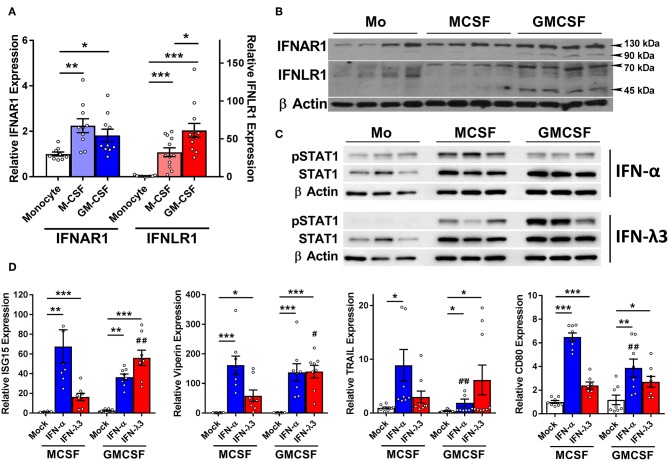
M-CSF and GM-CSF differentiated macrophages respond differently to IFN-α and IFN-λ3. Following M- and GM-CSF stimulated differentiation, IFN-λ responsiveness of Mϕ populations was examined, and compared to IFN-α. M-CSF and GM-CSF Mϕ subsets both increased the expression of IFNAR1 ~2-fold following differentiation from monocytes, and IFNLR1 transcripts ~30- and 60-fold, respectively (A) (n ≥ 9). Western blot of IFNAR1 and IFNLR1 from four healthy subjects confirmed these findings (B) (n = 7, total). Supporting these findings, phosphorylation of STAT1 was detected by Western blot in both monocytes and macrophages following 15 min of IFN-α treatment and macrophages only following IFN-λ3 (C). ISG transcripts for ISG15, viperin, CD80, and TRAIL were examined to measure Mϕ sensitivity to IFN-α (50 U/ml) and IFN-λ3 (100 ng/ml) (D) (n = 8). M-CSF differentiated Mϕs were more responsive to IFN-α, whereas GM-CSF differentiated Mϕs, IFN-λ3. Data are representative of two independent experiments. Paired t-test */#p < 0.05, **/##p < 0.01, ***p < 0.001 (mean ± SE). *Mock vs. IFN treatments, #M-Mϕ vs. GM-Mϕ.